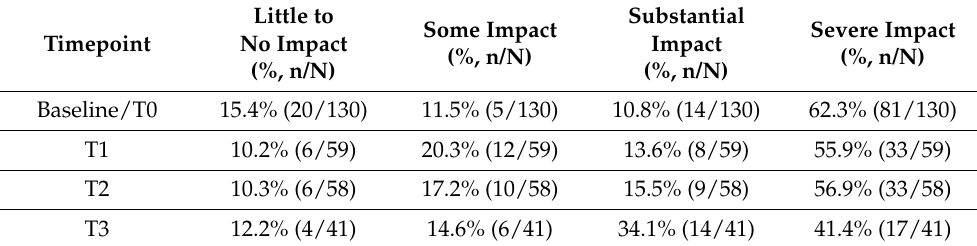
Table 3. Percentages of participants in HIT-6 headache disability categories by survey